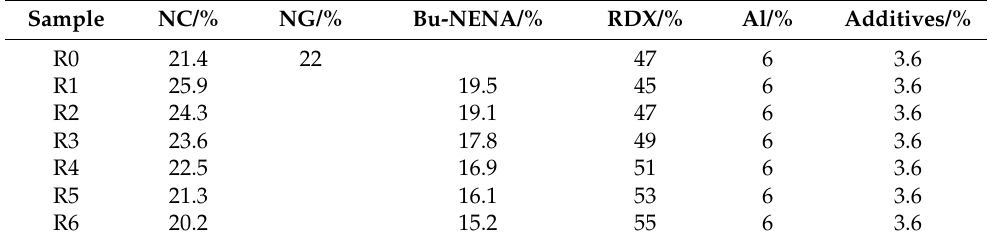
Table 1. The composition of EMDB propellant plasticized by Bu-NENA (wt.